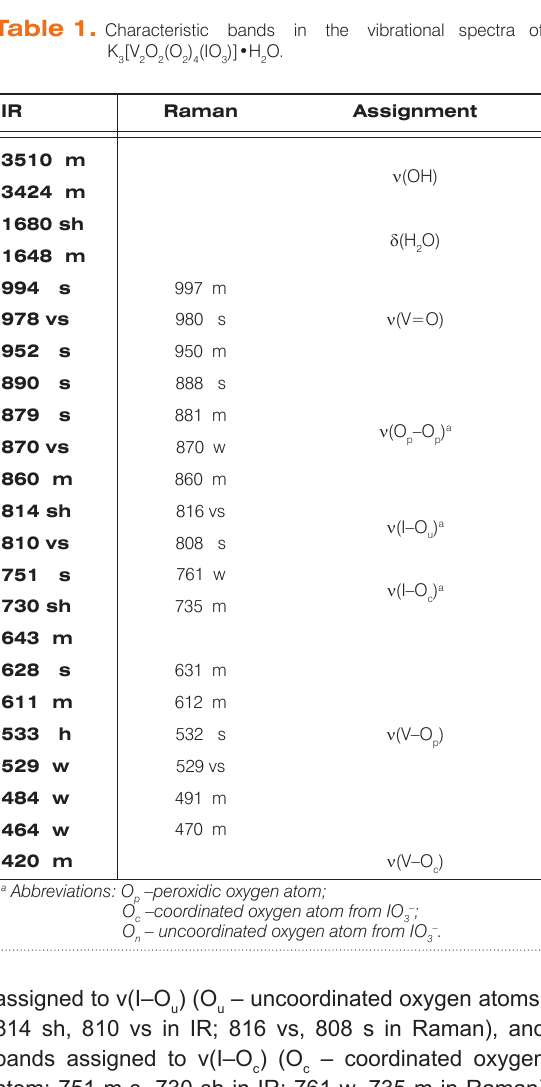
Table 1. Characteristic bands in the vibrational spectra of K